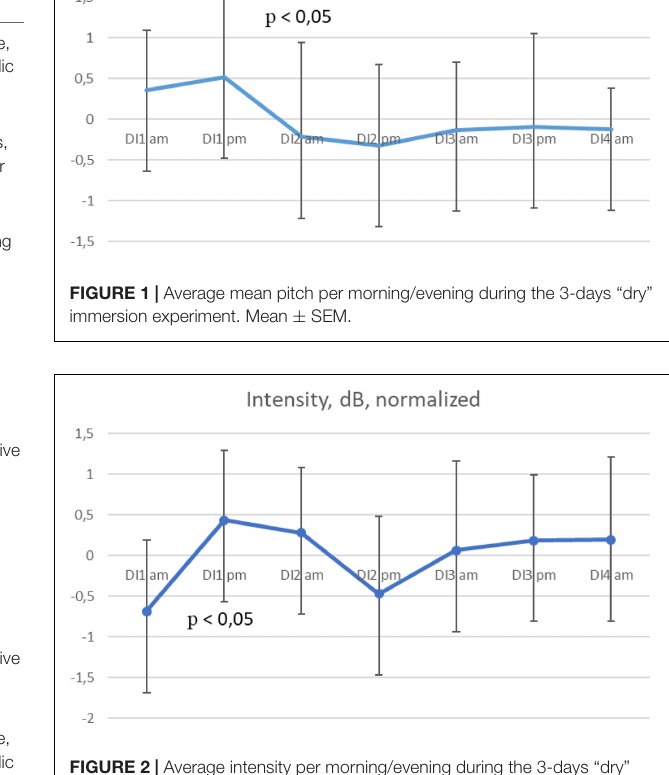
TABLE 1 | Design of the psychophysiological study of female 3-day dry immersion. Approaches and techniques used